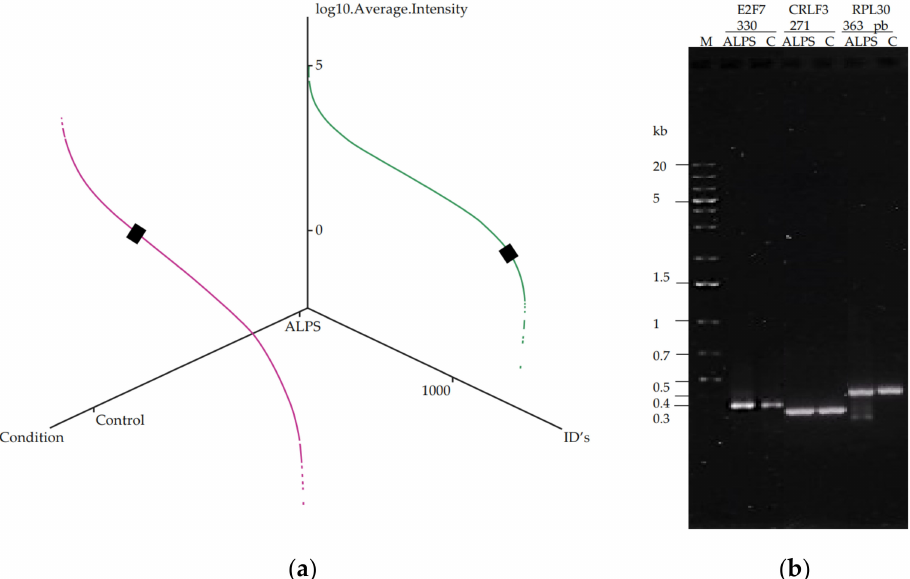
Figure 7. Molecular analysis of E2F7 in the ALPS-U patient. ( a ) Dynamic range of E2F7 expressed as base 10 logarithm. Magenta control, green ALPS-U samples. ( b ) Detection of E2F7 and CRLF3 by RT-PCR. RFLP30 was used as control.